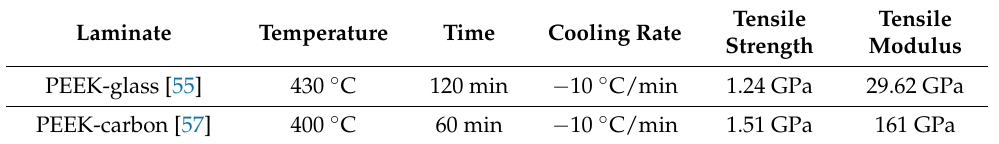
Figure 14. Mechanical properties in tensile of co-wrapped PLA-hemp laminates: ( a ) elastic modulus and ( b ) tensile strength. Adapted with permission from Reference [60]. Table 2. Optimal process parameters and